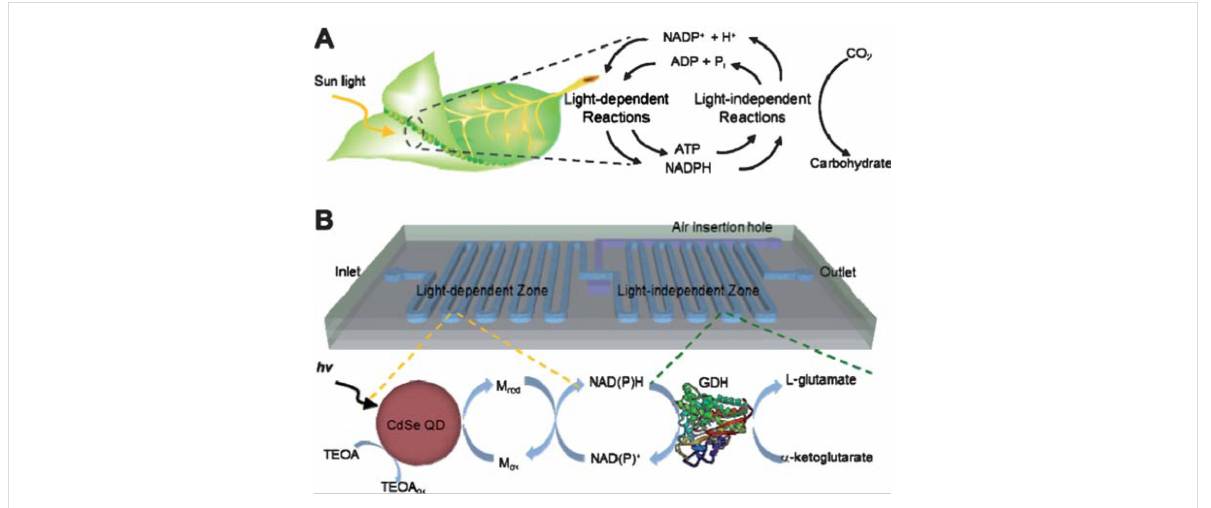
Figure 8: Microfluidic APS platform that incorporates quantum dots and redox enzymes for photoenzymatic synthesis. (A) Concept and (B) besign of microreactor in which the cofactor regeneration takes place in the light-dependent reaction zone and the enzymatic synthesis in the light-independent zone. Adapted from [88], copyright 2011 Royal Society of Chemistry.